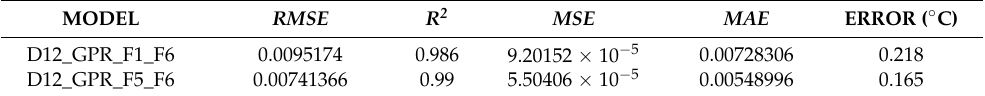
Table 9. D12 mean performance metrics on empirical data across five splits.